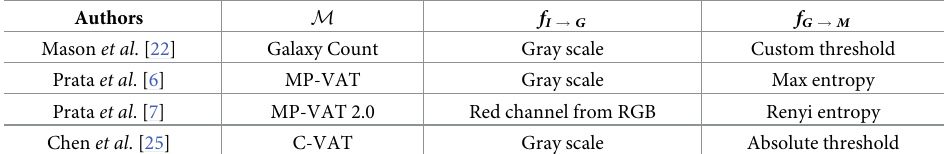
Table 2. Differences between TR-based models. All existing methods consist of a channel extracting step ( f a thresholding step ( f G ! M